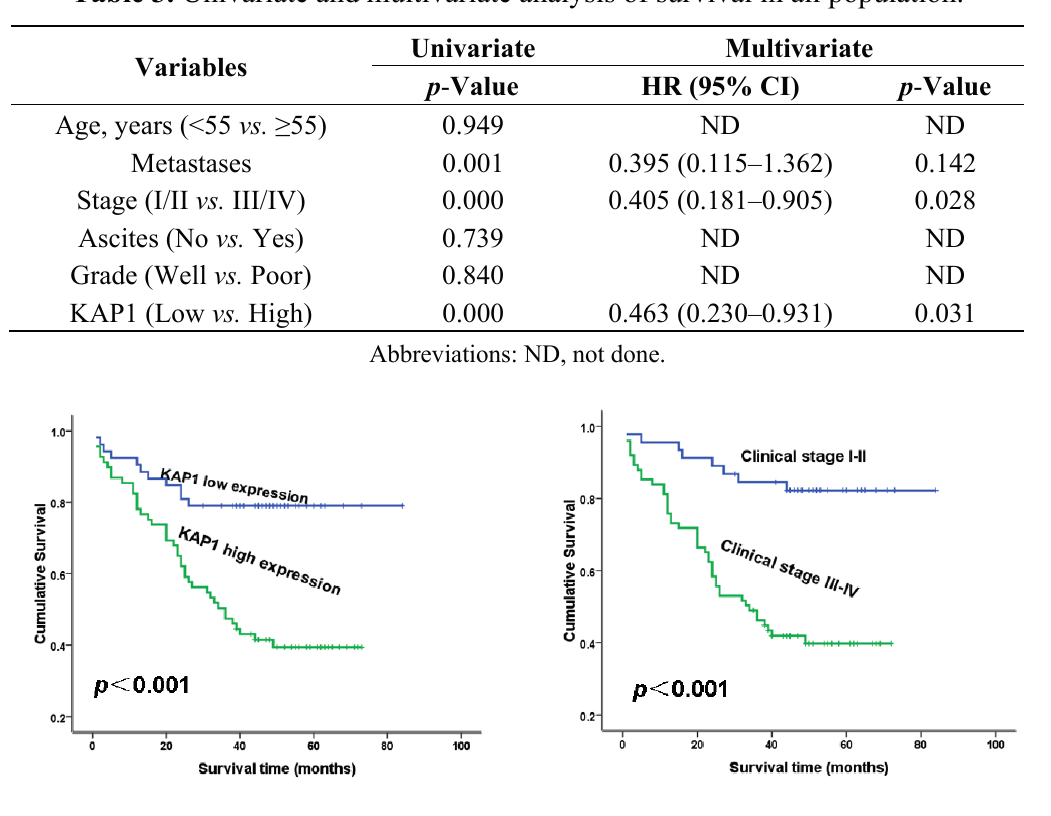
Table 3. Univariate and multivariate analysis of survival in all population.